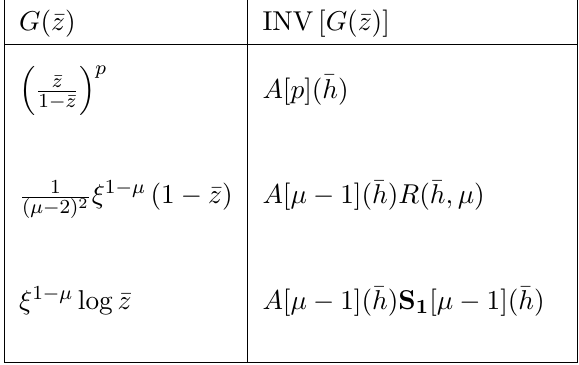
Table 4 . Inversions for G ((cid:22) z ) containing non-integer powers of (1 (cid:0) (cid:22) z ). (cid:2) (cid:3) INV (cid:24) 1 (cid:0) (cid:22) = A [ (cid:22) (cid:0) 1]((cid:22) h ).